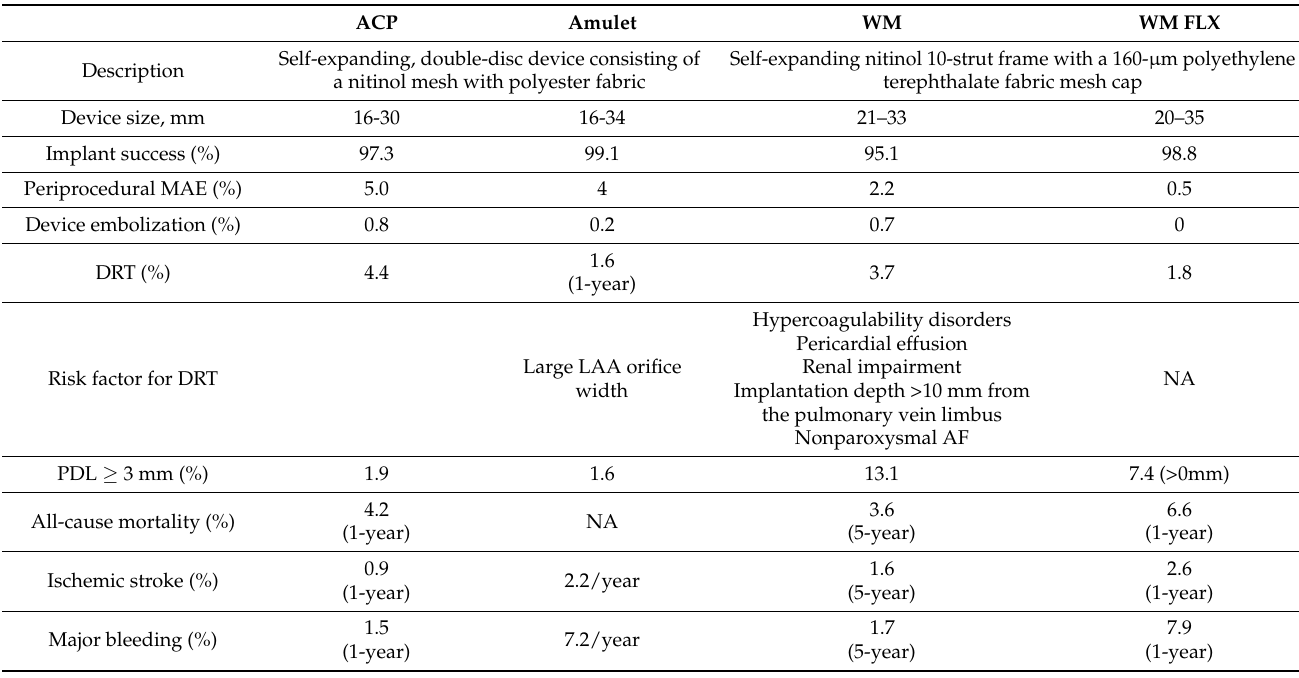
Table 2. Characteristics and clinical outcomes of the most well-studied left atrial appendage (LAA) closure